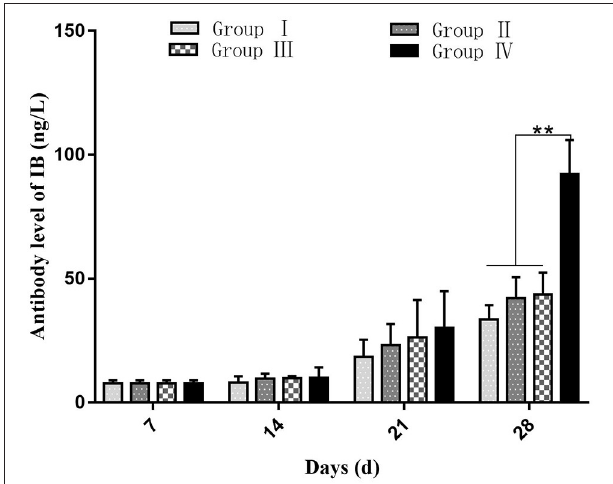
FIGURE 1 | Effect of SGDL granule or doxycycline and both on the antibody response to vaccination against IBV. Group I served as a control. Broilers in Group II were given doxycycline whereas Group III was given SGDL granule through drinking water. Broilers in Group IV were given SGDL granule and doxycycline in drinking water. Extremely significant ( p < 0.01) different values are shown with **, and no signal was not significantly ( p > 0.05) different between the groups at those time points. SGDL,